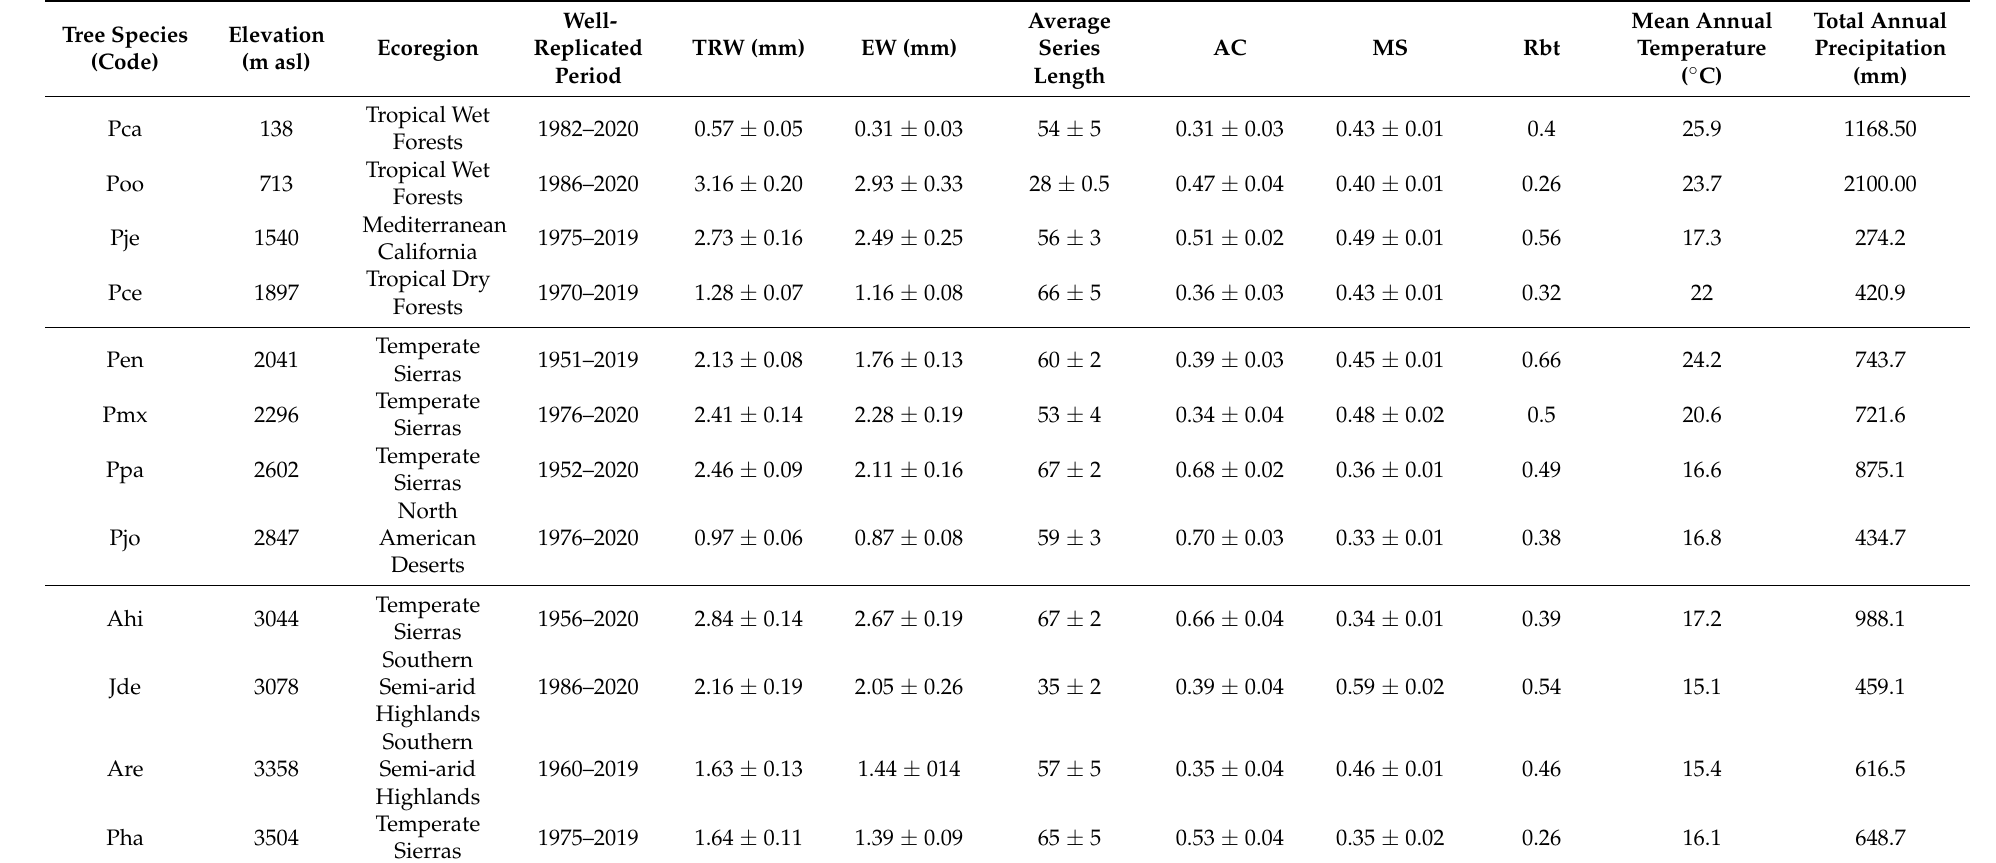
Table 1. Dendrochronological statistics per species and characteristics of the